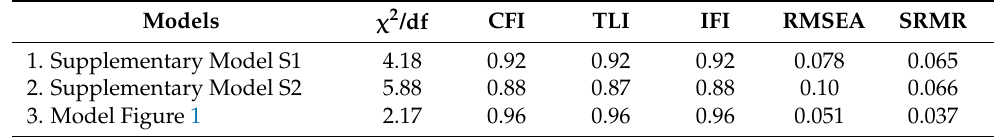
Table 2. Comparison between the different